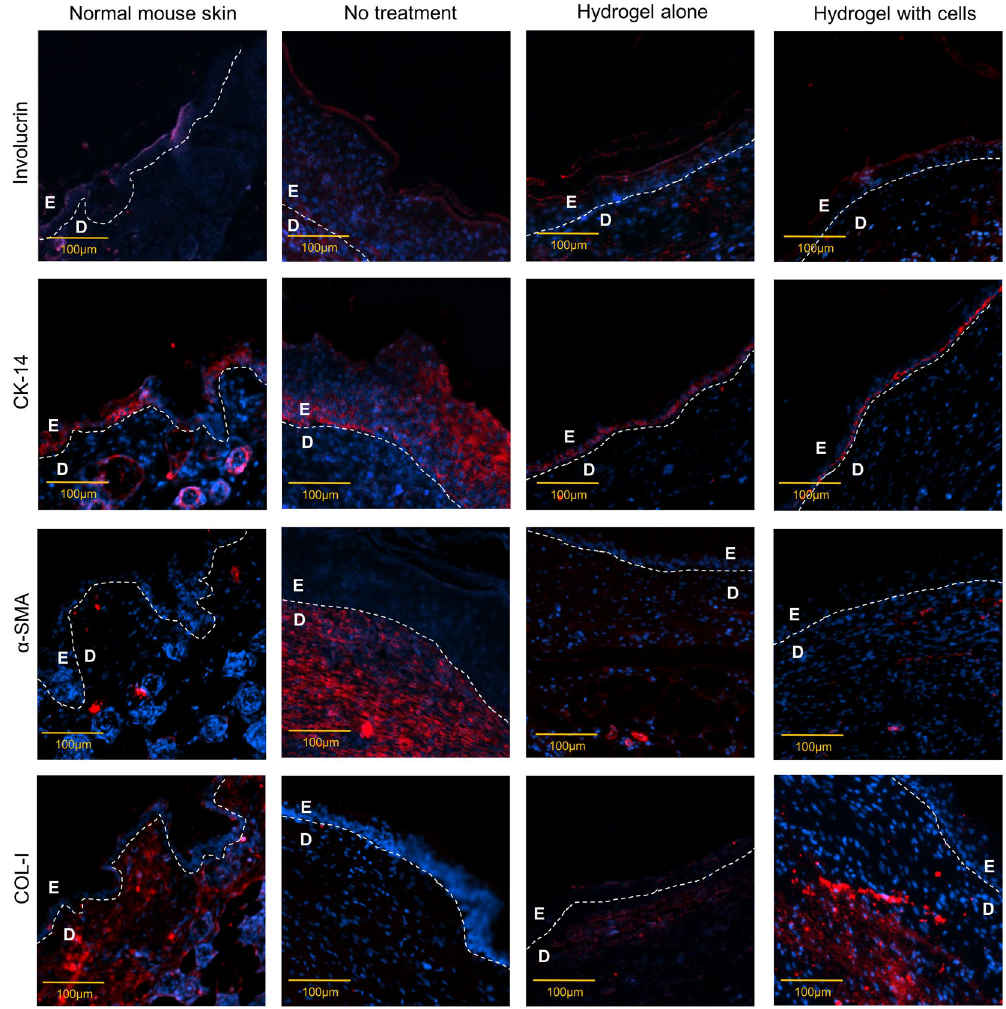
Figure 6. Immunohistochemical staining of involucrin, CK-14, α -SMA, and COL-I for different treatment groups under 100 × magnification. E refers to the epidermis layer; D refers to the dermis layer. Nucleus stained blue, specific markers stained